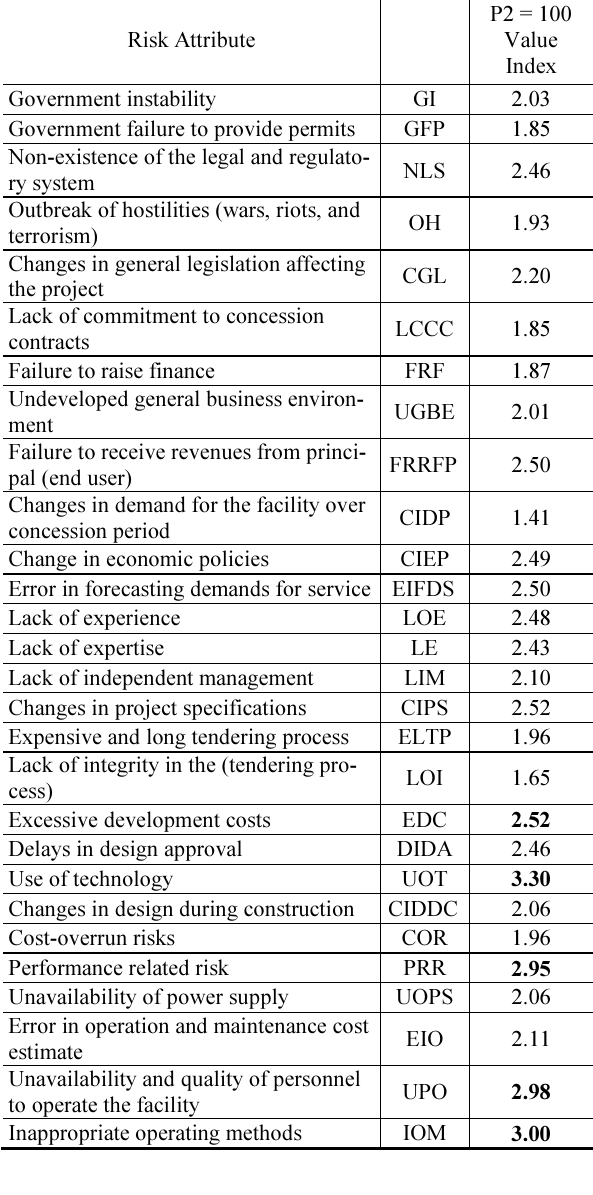
Table 8. Risk index value for the Sulaibiya Wastewater Treat- ment plant project in Kuwait